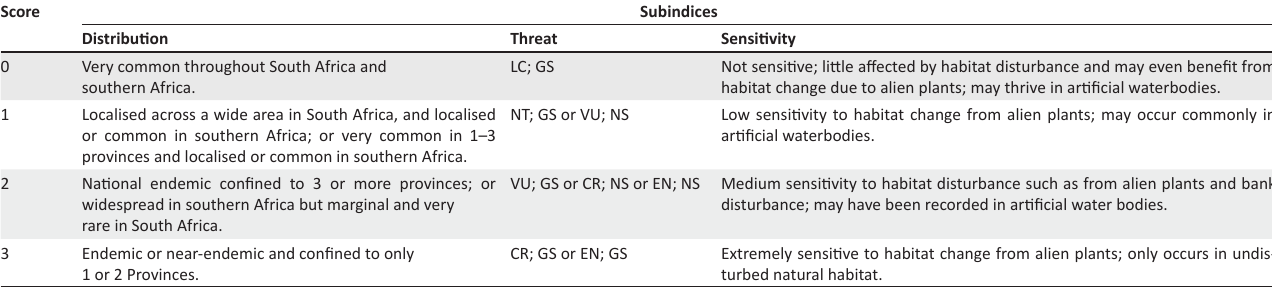
Source : Table modified from Simaika, J.P. & Samways, M.J., 2008, ‘Valuing dragonflies as service providers’, in A. Cordoba-Aguilar (ed.), Dragonflies: Model organisms for ecological and evolutionary research , pp. 109−123, Oxford University Press,